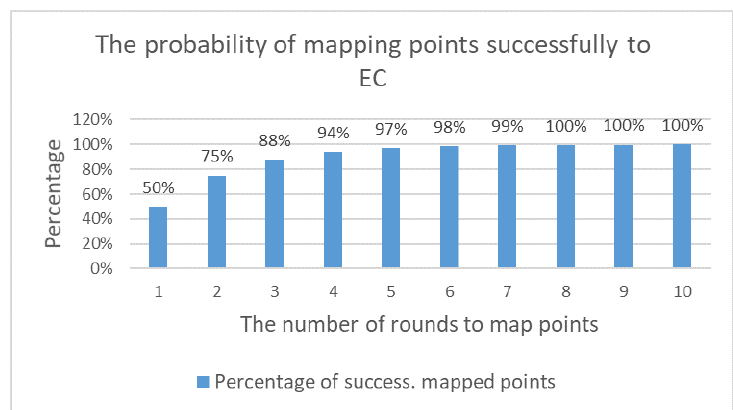
Figure 29. Probability of successfully mapping points to an elliptic curve based on number of rounds.